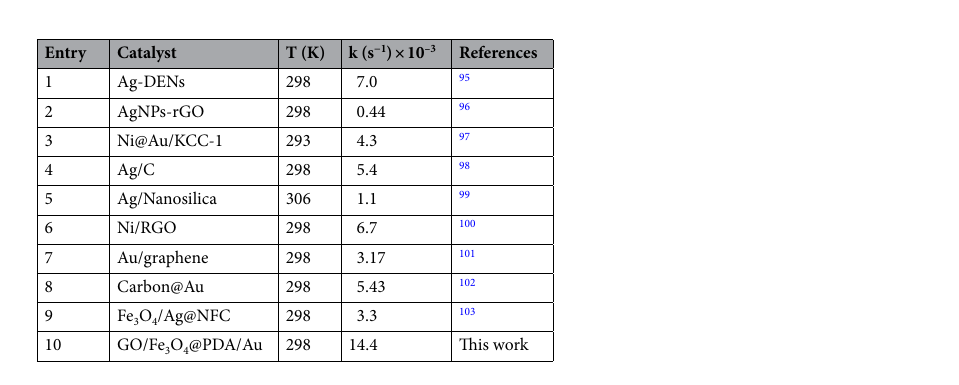
Table 3. Comparison of catalytic results between GO/Fe 3 O 4 @PDA/Au with some reported methods in the reduction of